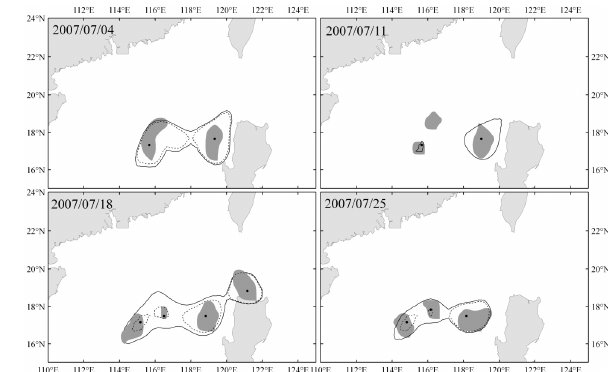
Fig. 10. Evolution snapshots of ACE2’s splitting event. The dots Figure 10. Evolution snapshots of ACE2’s splitting event. The dots represent eddy centers 2 represent eddy centers, while the dark grey polygons represent eddy while the dark grey polygons represent eddies’ core areas. The composite border is delineated 3 core areas. The composite border is delineated by the solid line, by the solid line while the footprint border is delineated by the dashed line. 4 while the footprint border is delineated by the dashed